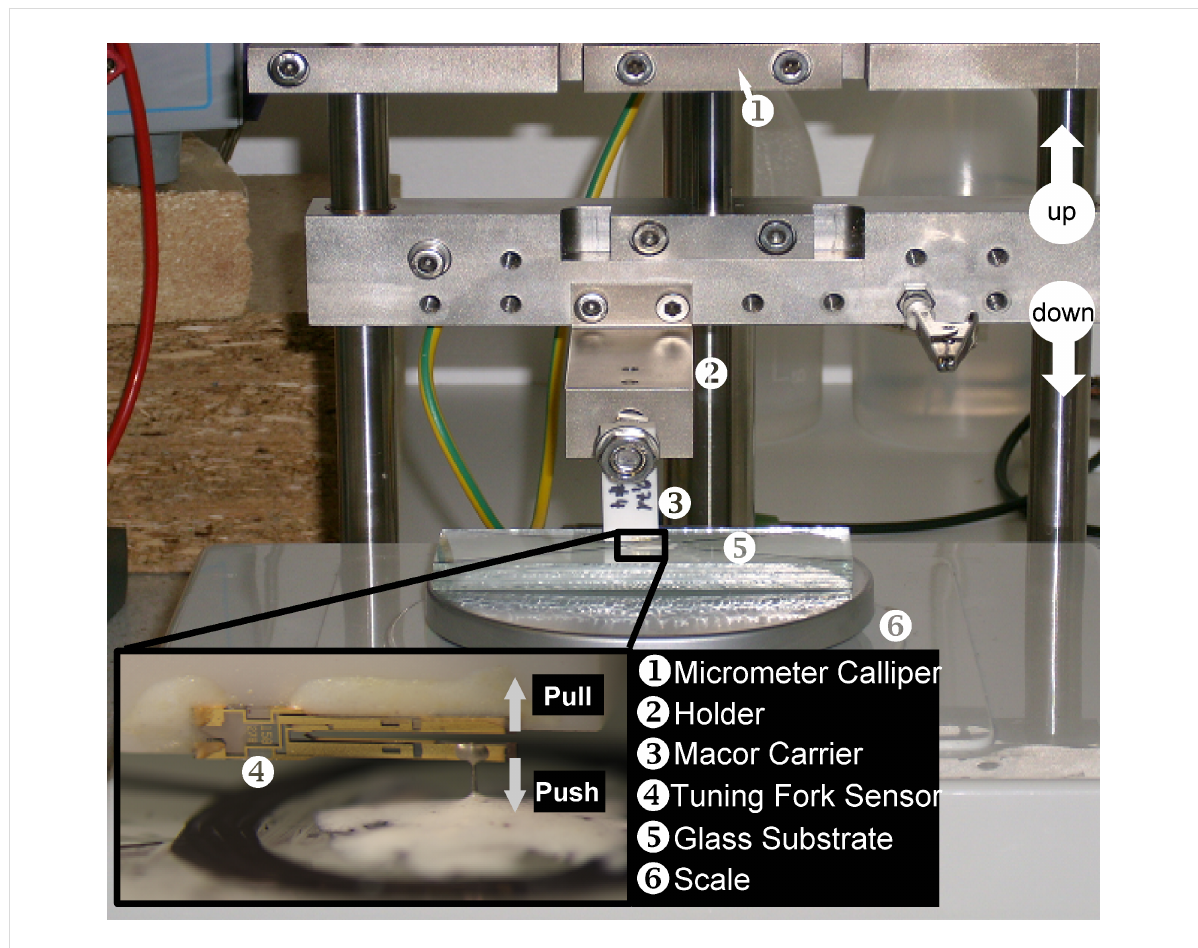
Figure 2: Photograph of the experimental setup. Not shown in the picture is the micrometer screw 1, which pushes or pulls the whole setup towards or from the scale. The Macor body 3, carrying the tuning fork sensor 4 is fixed to the holder 2. The inset shows a close-up of the tuning fork. The tuning fork is glued onto a Macor basis as in actual force sensors while the wire tip at the free prong is glued to a glass substrate. Latter transfers the force to the scale and delivers the mass for also pull the sensor away from the